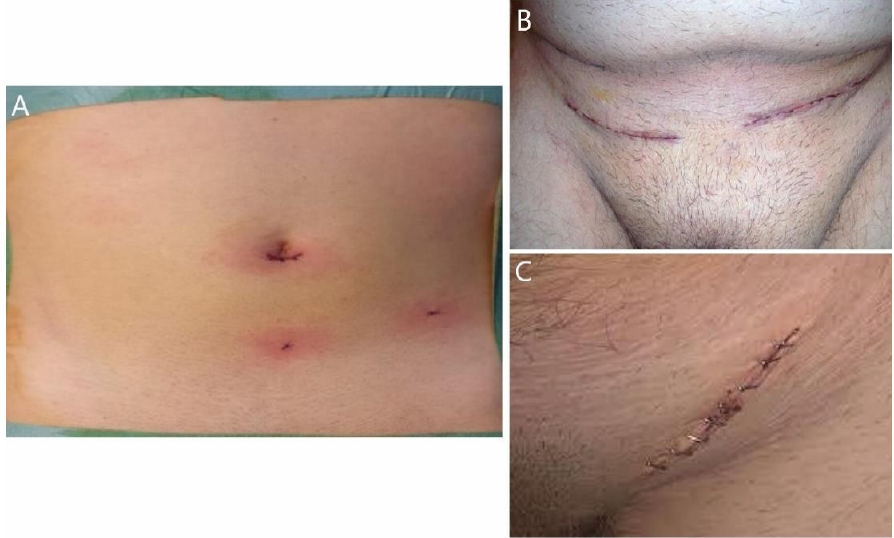
Figure 2. ( A ) Laparoscopy procedure; ( B , C ) open approach procedure.